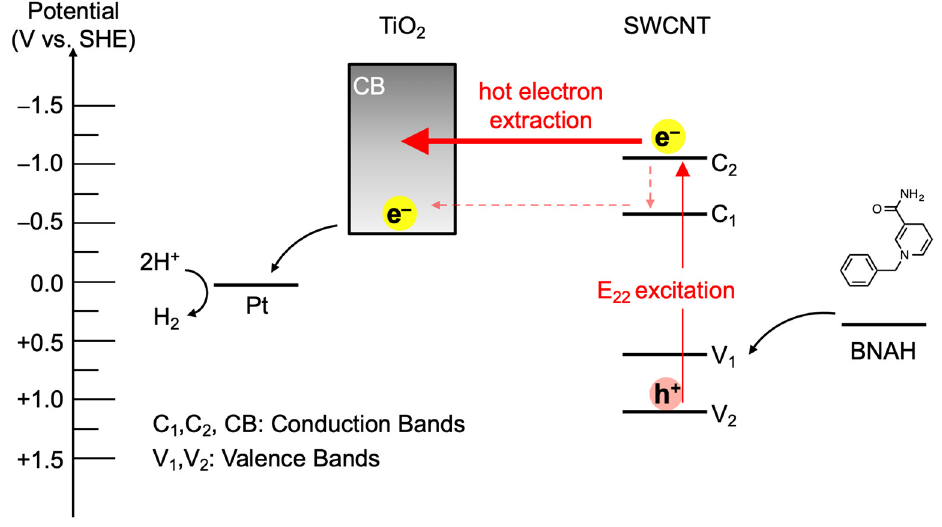
Figure 5. Energy-level diagram of the hydrogen evolution reaction using SWCNT/TiO 2 /Pt as a photocatalyst in the presence of BNAH as a sacrificial donor.